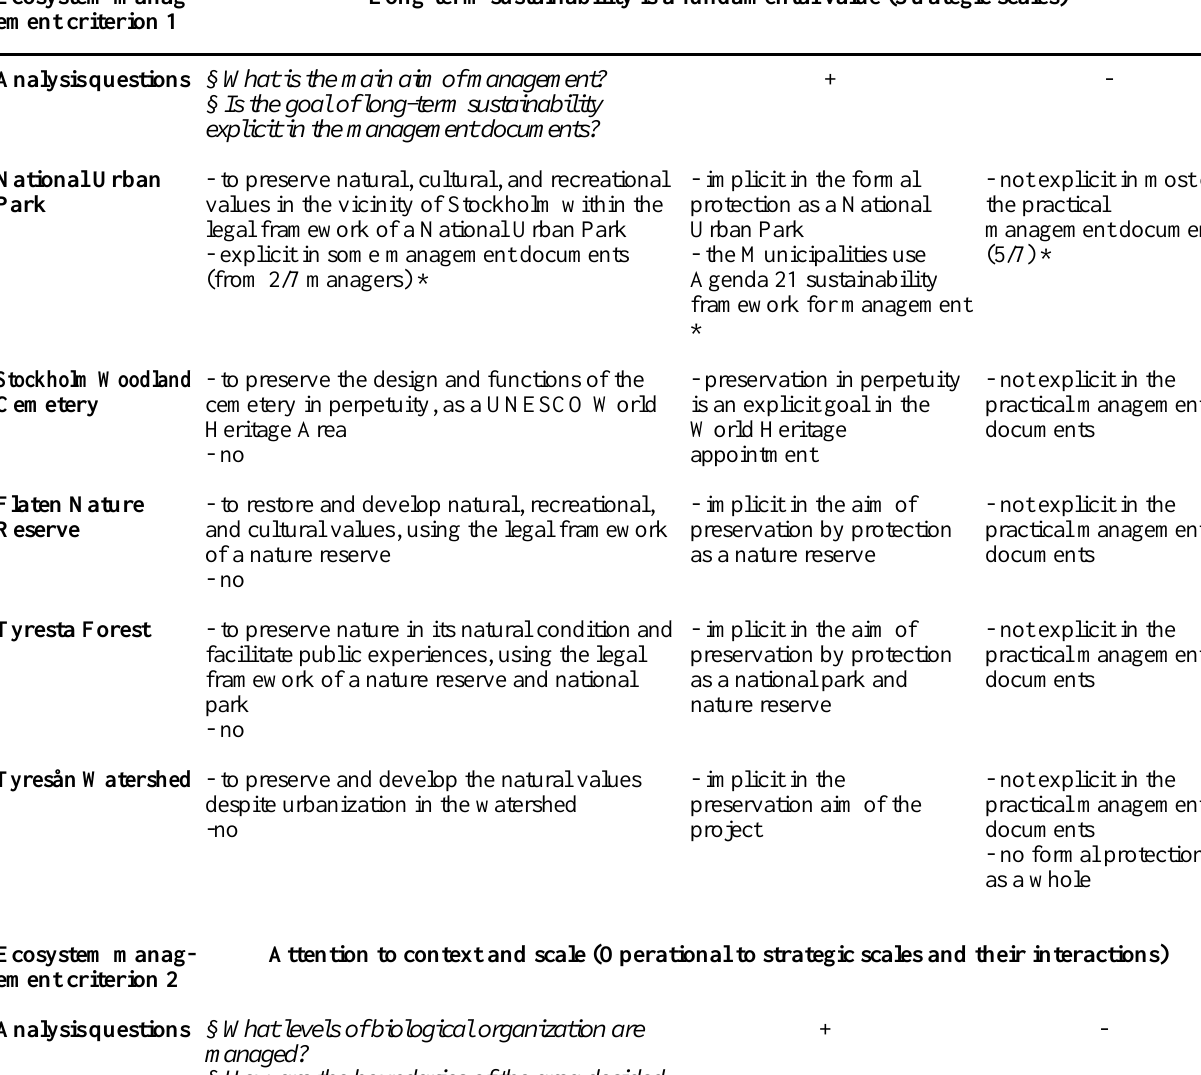
Table 1. Analysis results for each green space in relation to the ecosystem management criteria (Christensen et al. 1996) and the analysis questions. The results are interpreted as indicating (+) or not indicating (-) criteria fulfillment. For case-specific references, see Append. 3. * indicates that the statement is only valid for some managers in the National Urban